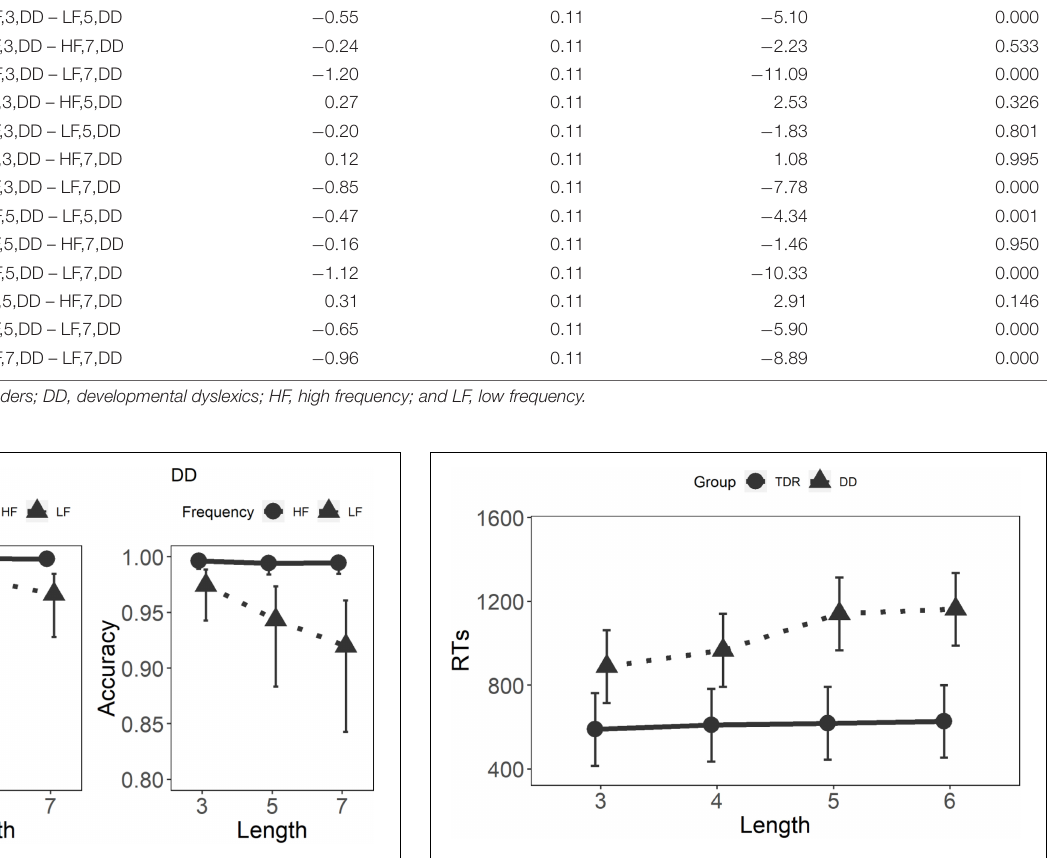
FIGURE 4 | Two-way interaction on non-words. TDR, typical developing readers; DD, developmental dyslexics; and RTs, reaction times. (Zoccolotti et al., 2005; Davies et al., 2007; Richlan et al., 2010; Suárez-Coalla and Cuetos, 2015) and with children